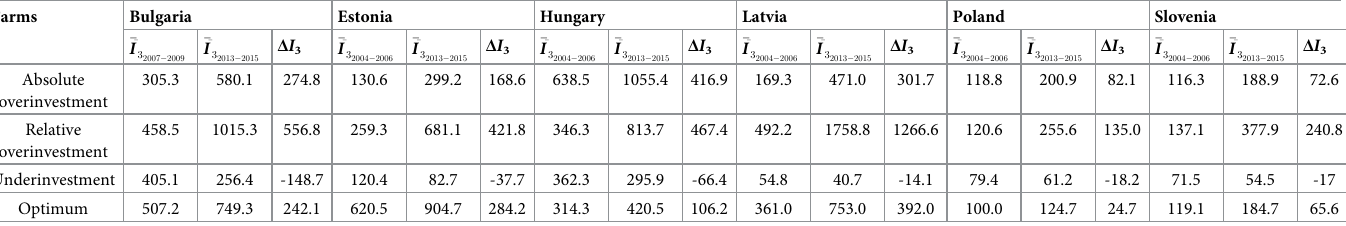
Table 4. Resources of fixed assets other than land (EUR thousand per farm) in farms grouped by scale of investment in 2007–2009 and 2013–2015 ( I